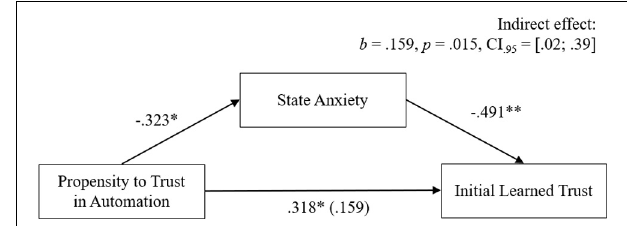
FIGURE 6 | Findings for the mediation from the propensity to trust to initial learned trust by state